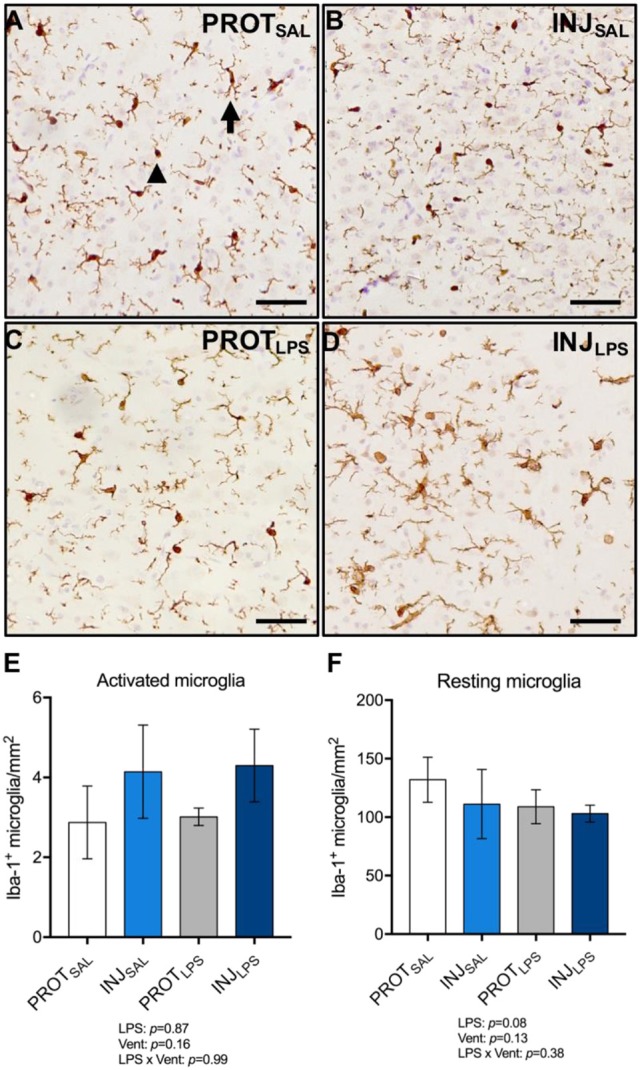
LPS exposure, irrespective of ventilation strategy, does not change the number of activated or resting microglia in the cortical gray matter. Representative images of Iba-1+ microglia in the gray matter (A–D). LPS exposure did not significantly change the number of activated (amoeboid; arrowhead) microglia (E), or resting (ramified; arrow) microglia (F). Magnification = 2x, scale bar = 20 μm. PROTSAL, N = 5; PROTLPS, N = 6; INJSAL, N = 6; and INJLPS, N = 5.